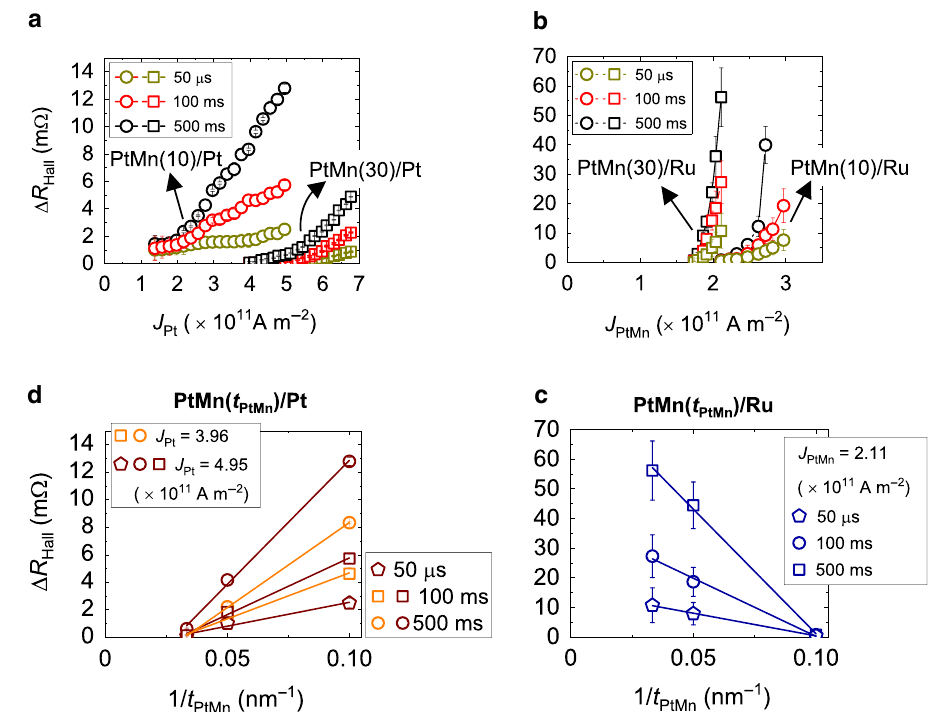
Fig. 3 AFM thickness dependence of current-induced switching in PtMn/Pt and PtMn/Ru structures. ( a ), ( b ) Dependence of the change in Hall resistance ( Δ R Hall ) as a function of write current densities J Pt and J PtMn for PtMn(10 or 30)/Pt and PtMn(10 or 30)/Ru structures, respectively, for various pulse widths τ P = 50 µ s, 100 ms and 500 ms. ( c ), ( d ) Inverse of AFM thickness ( t PtMn ) dependence of Δ R Hall for PtMn/Pt and PtMn/Ru, respectively. Solid lines in ( c ), ( d ) are guides to the